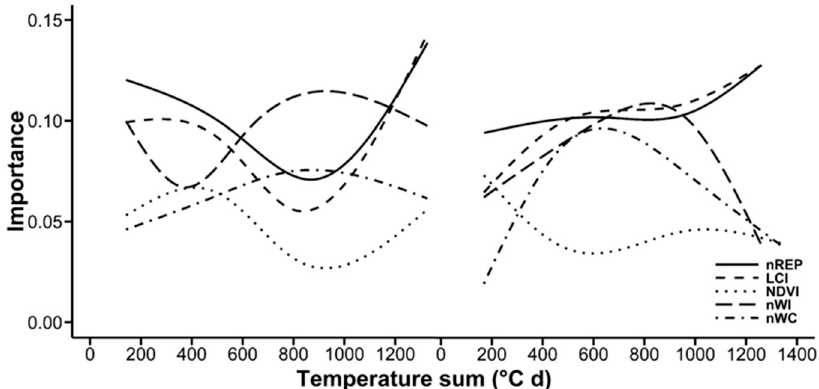
Figure 6. Importance of nREP, LCI, NDVI, nWI and nWC in Growth 1 and Growth 2. For single data points, see Supplement Tables S5 and S6.